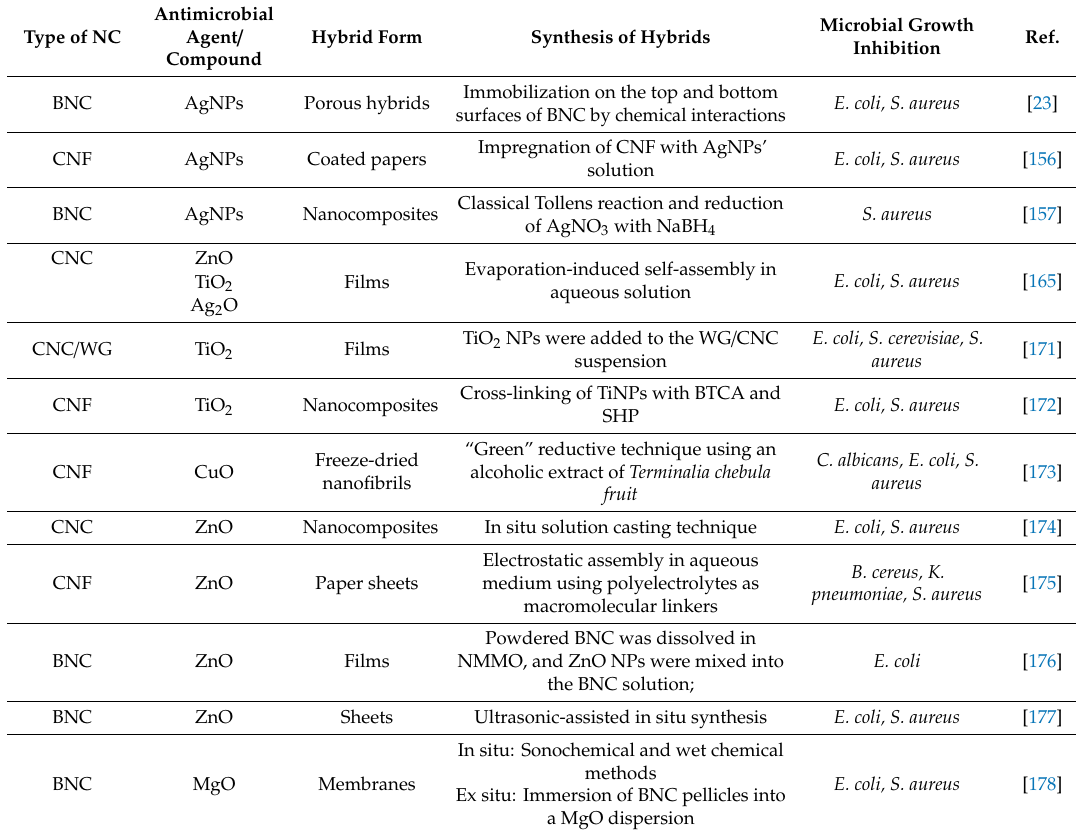
Table 4. Diverse inorganic NC-based antimicrobial